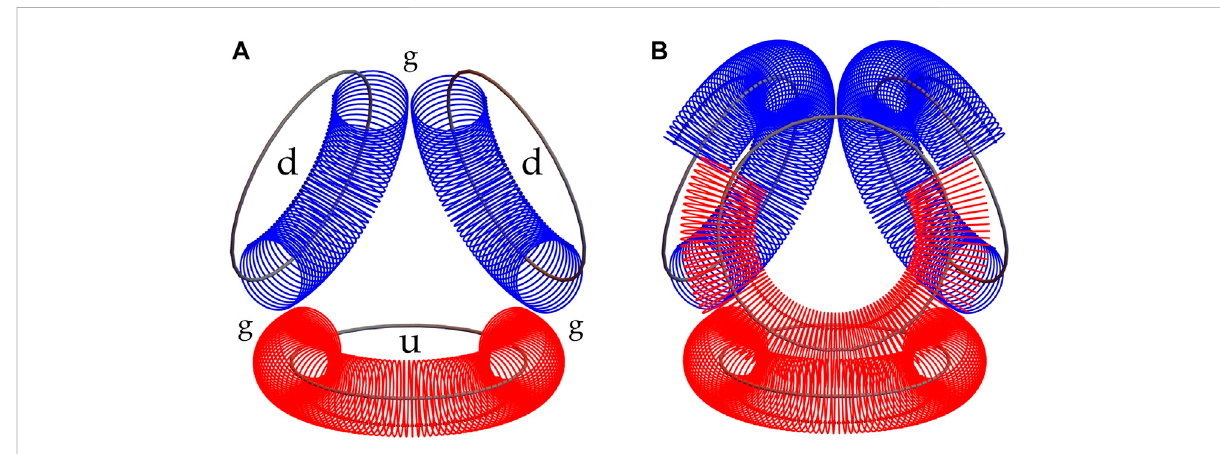
FIGURE 2 (A) Model of the neutron. The up quark (u) comprising 92 quanta is a 2 / 3 arc of the full torus (the positron) comprising 138 quanta. Accordingly, each of the two down quarks (D) comprising 46 quanta is a 1 / 3 arc of the full torus of opposite handedness (the electron). The quarks cannot but coordinate in tetrahedral symmetry when connected via gluons (g), i.e., short-wavelength photons. The neutron is a closed, signed geodesic, i.e., a least-actionpathwithasenseofcirculation. (B) Modeloftwoneutronsinthedoublycompactcon fi gurationofadibaryon.Underhighpressure, the consecutive down quarks may bud out the gluon and fuse into up antiquark (Illustrations by Mathematica).